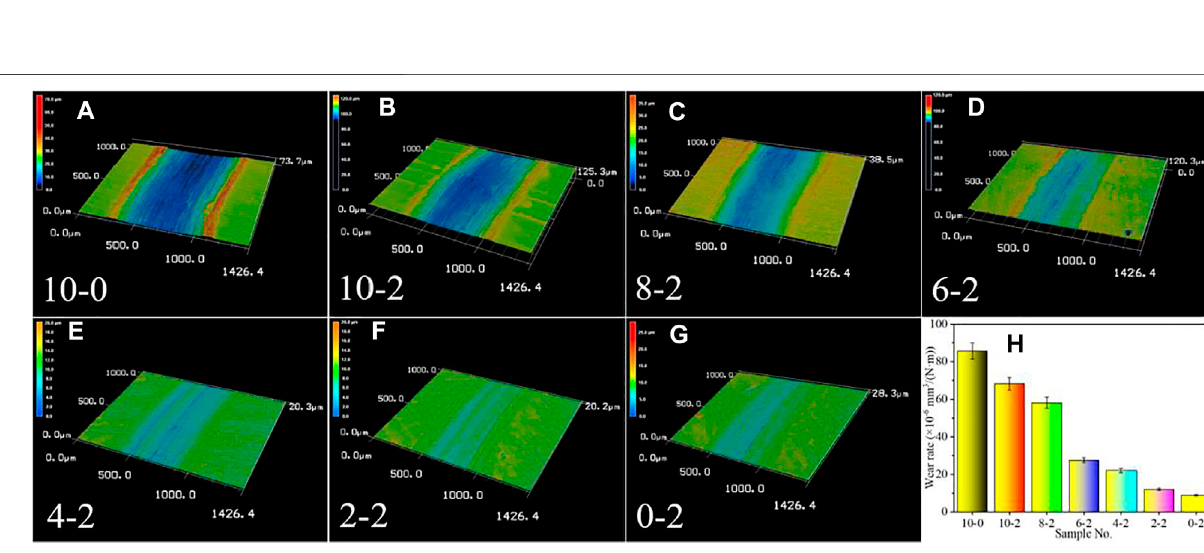
Frontiers in Materials |